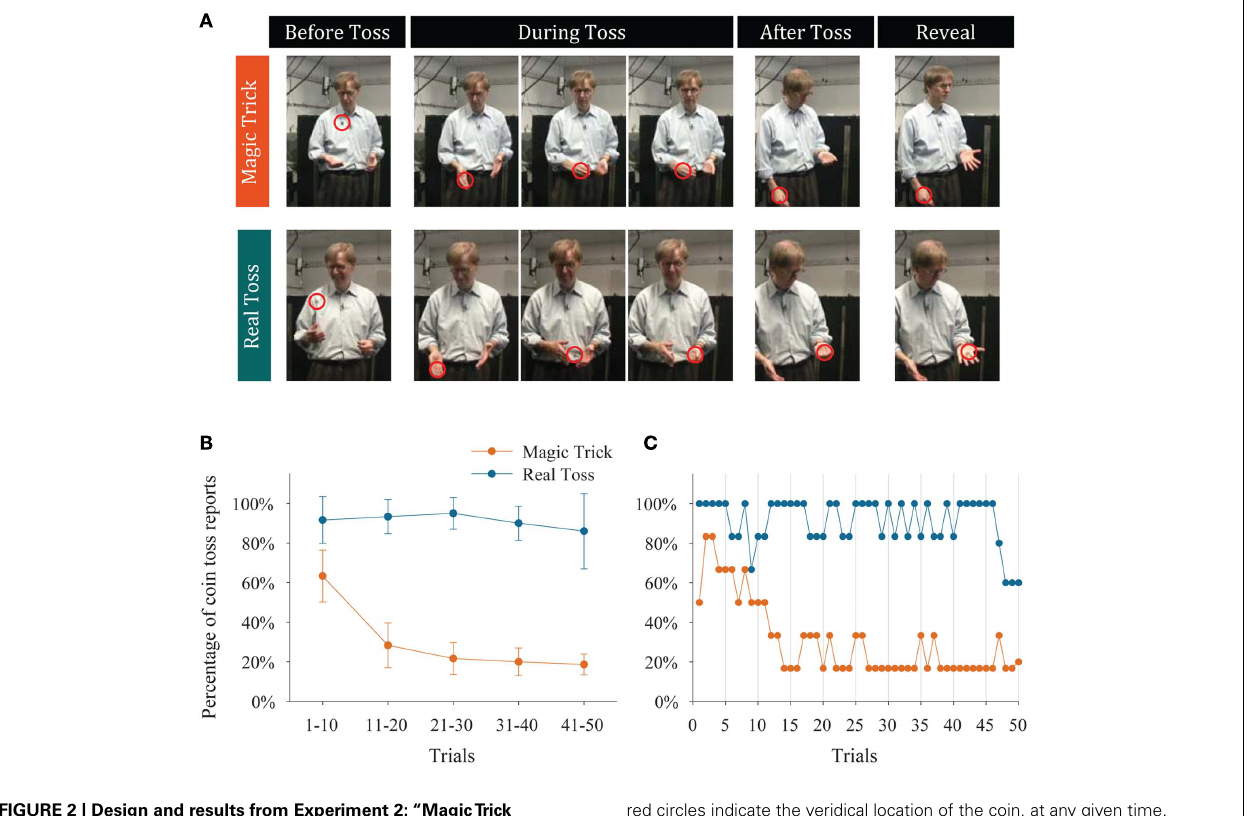
FIGURE 2 | Design and results from Experiment 2: “MagicTrick versus RealToss, with Reveal.” (A) Sequence of static images selected from the MagicTrick with Reveal (Upper Row) and RealToss with Reveal (Lower Row) video clips.The “Reveal” image selected for both video clips corresponds to the last frame of the performance.The